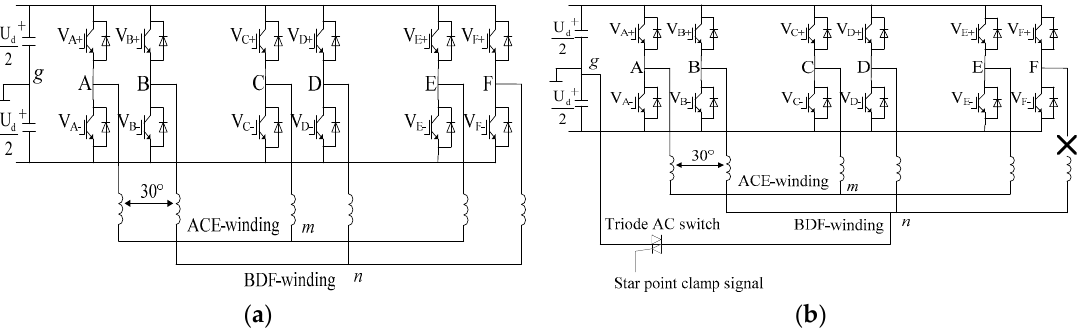
Figure 1. System composed of the converter and six-phase machine with double Y-connected windings displaced by 30°. ( a ) Circuit configuration under normal condition; ( b ) Circuit configuration under F-phase open-circuit fault condition.